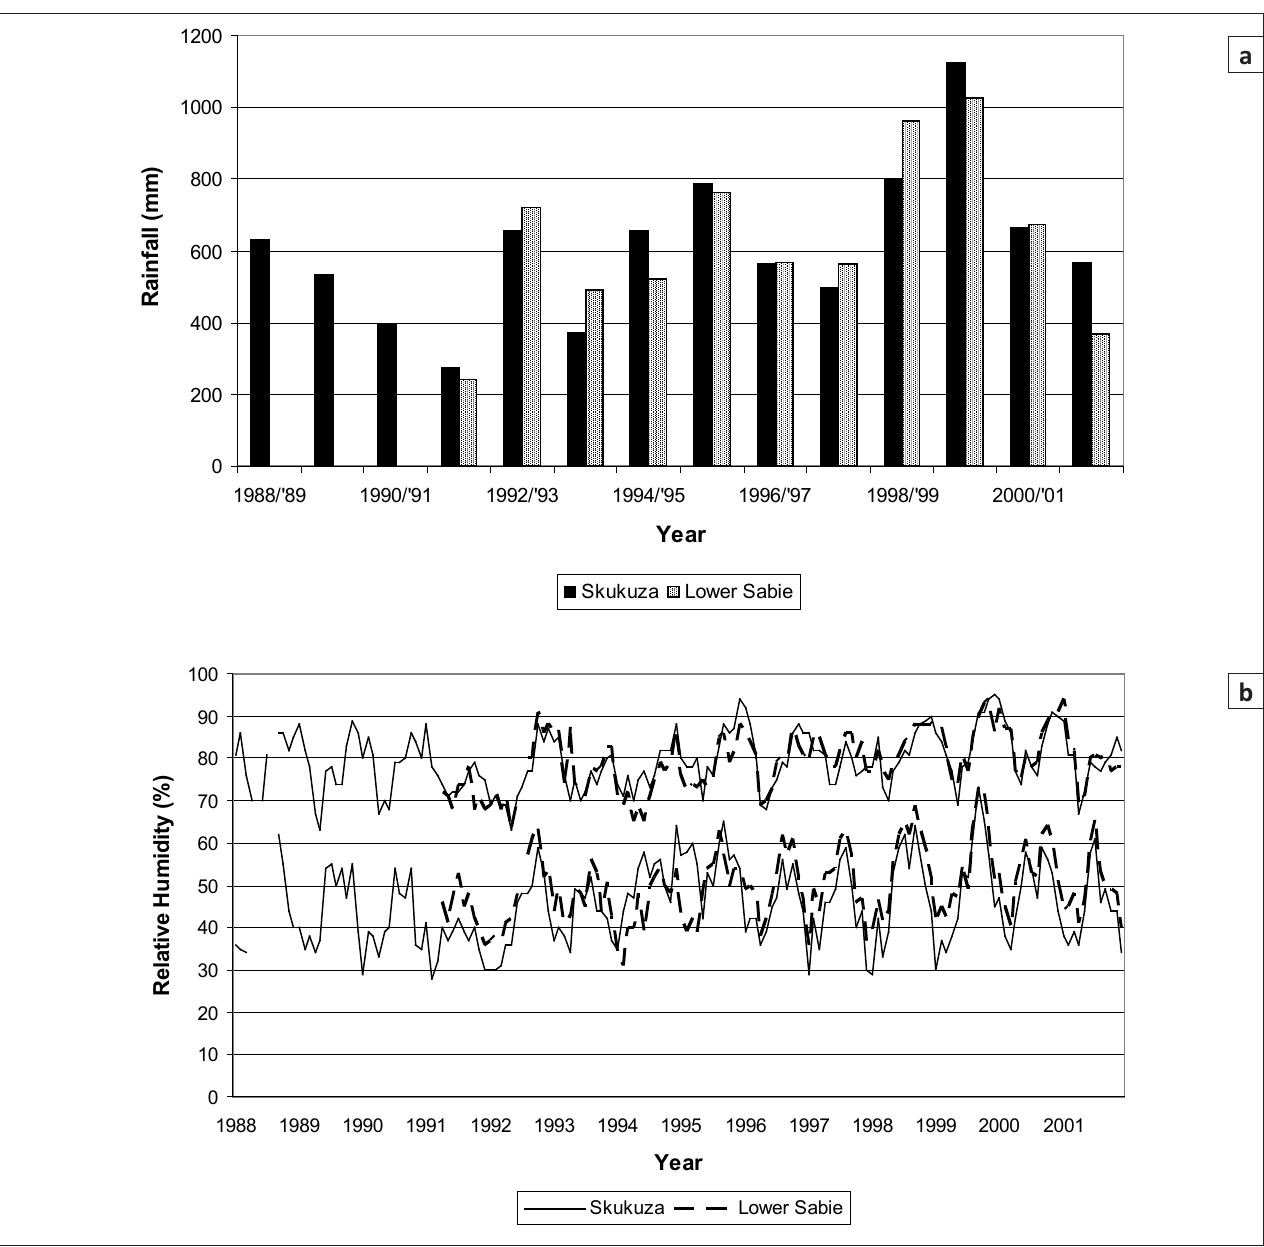
Upper set of curves represents humidity readings at 08:00; the lower set represents humidity readings at 14:00 at each of the sites. Weather readings commenced only during 1991/1992 at Lower Sabie. FIGURE 1: a) Annual (June–May) rainfall and b) mean monthly relative humidity during the study period at Skukuza and Lower Sabie.